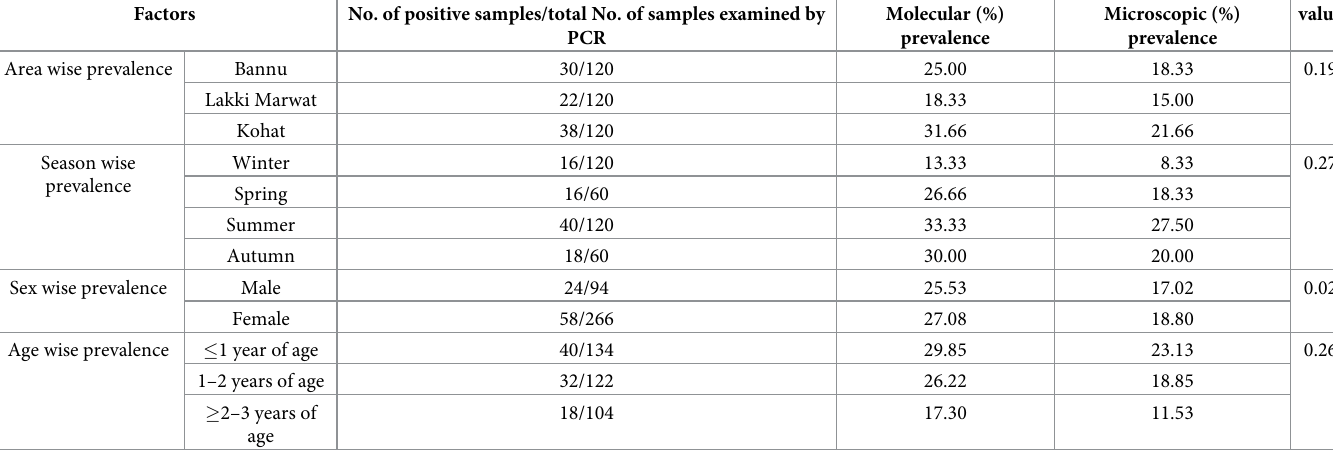
Table 5. Comparative evaluation of the sensitivity of two diagnostic techniques (PCR & microscopy) for detection of Cryptosporidium infection in sheep. Factors No. of positive samples/total No. of samples examined by